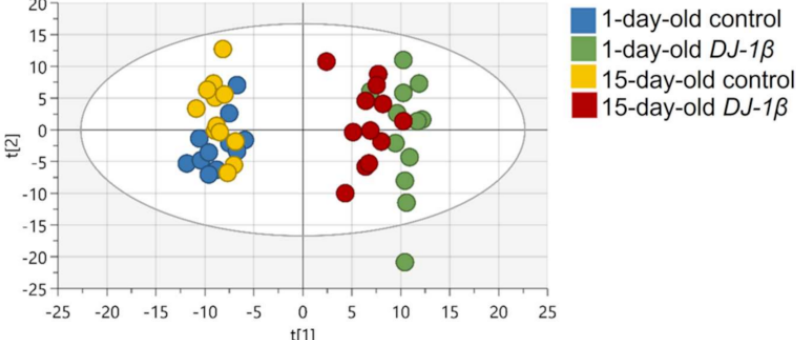
Figure 1. PCA-X score plots for all four experimental groups: 1-day-old control flies (blue), 1-day-old DJ-1 β mutant flies (green), 15-day-old control flies (yellow) and 15-day-old DJ-1 β mutant flies (red).